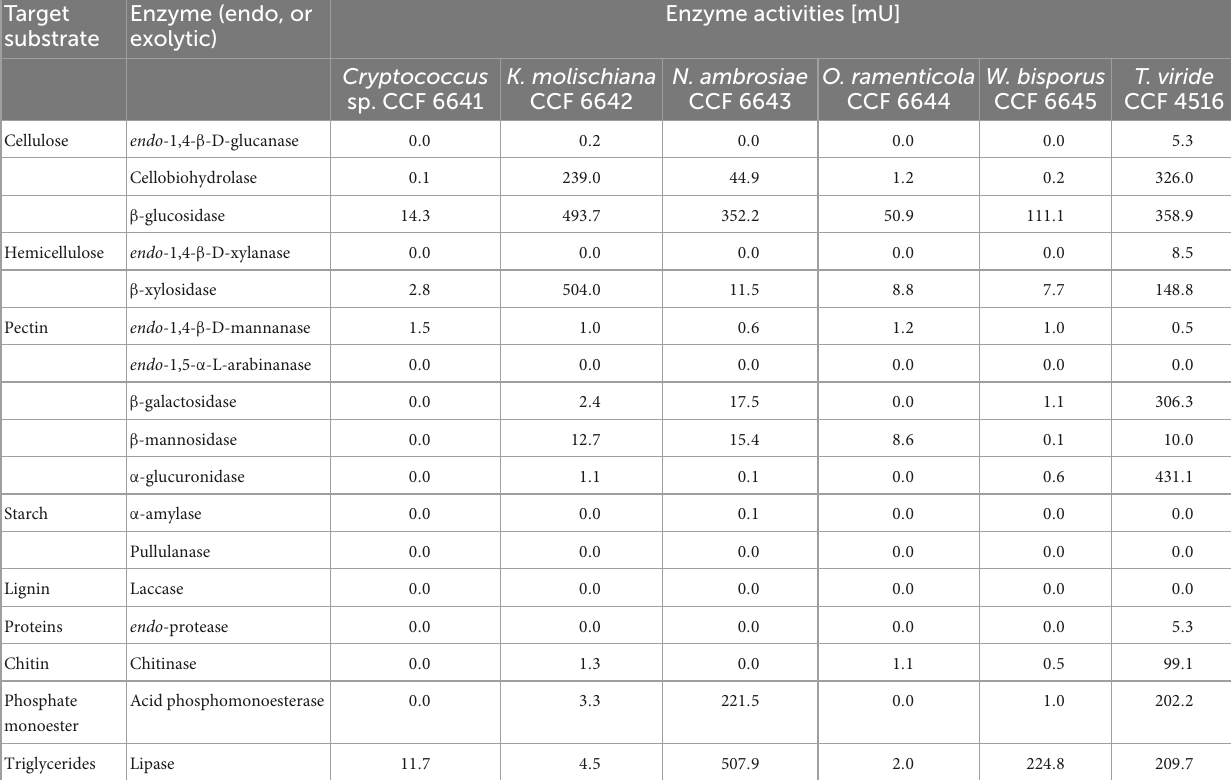
TABLE 4 Enzymatic activities of the studied yeasts. Target